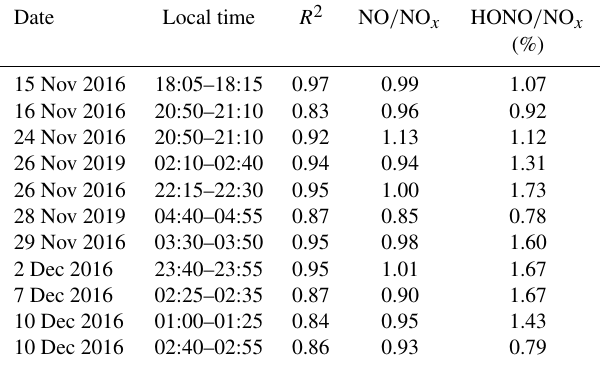
Table 3. Emission ratios (HONO / NO x ) of the fresh direct emission